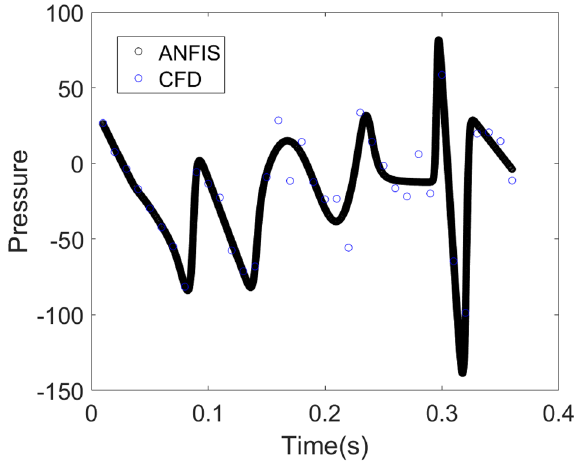
Figure 10. Time series calculation of pressure near the sparger orifice by CFD and